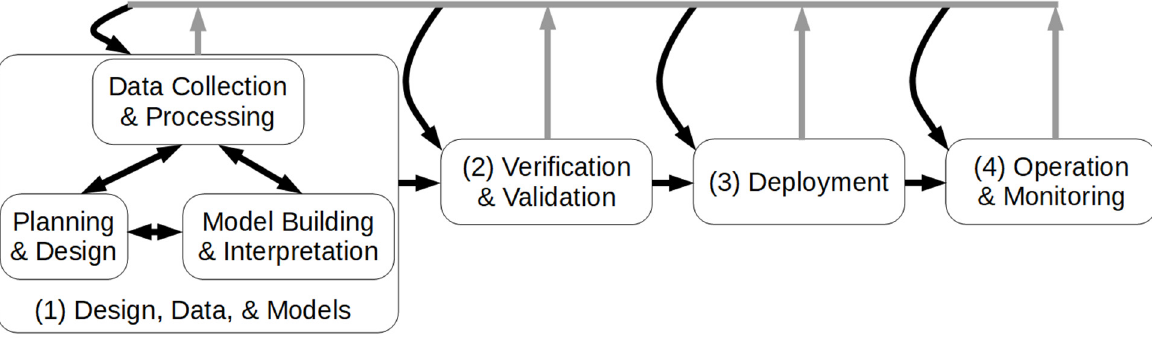
Figure 1. AI system lifecycle.